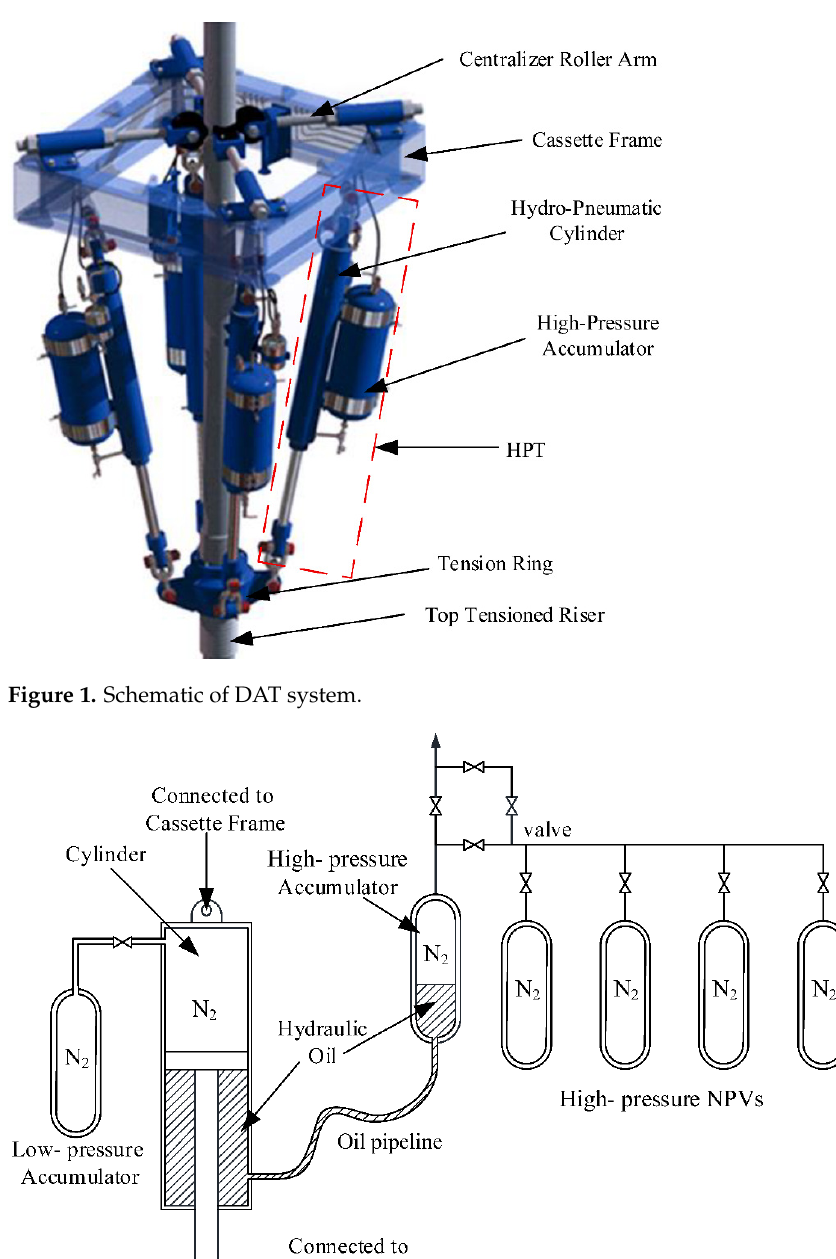
Figure 1. Schematic of DAT system.